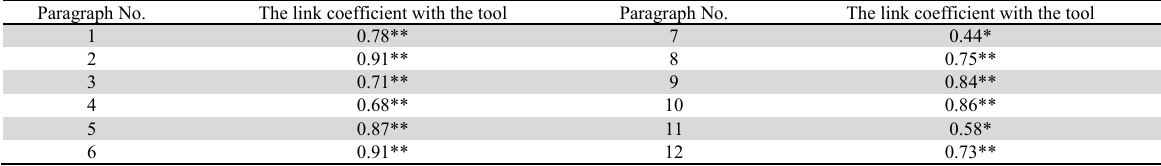
Correlation coefficients between paragraphs and the overall degree of the trend scale Paragraph No. The link coefficient with the tool Paragraph No. The link coefficient with the tool 1